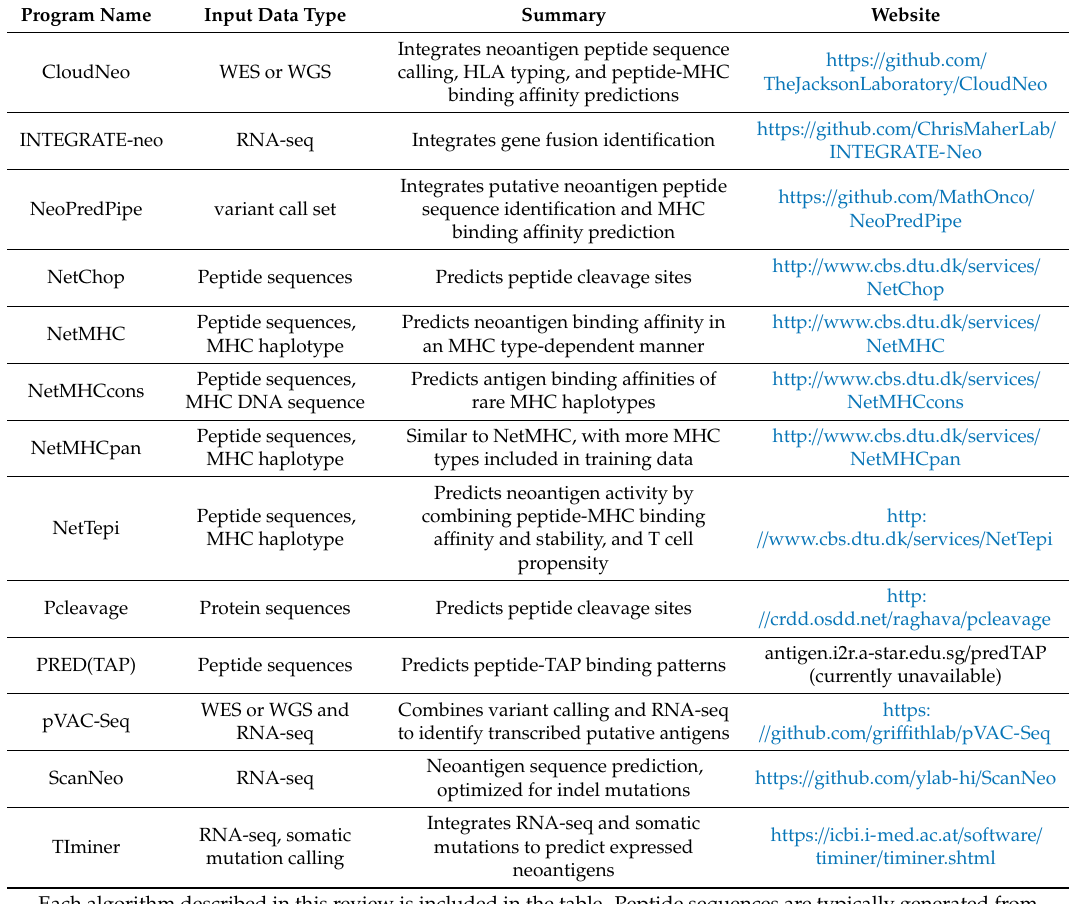
Table 1. Bioinformatics methods available for neoantigen